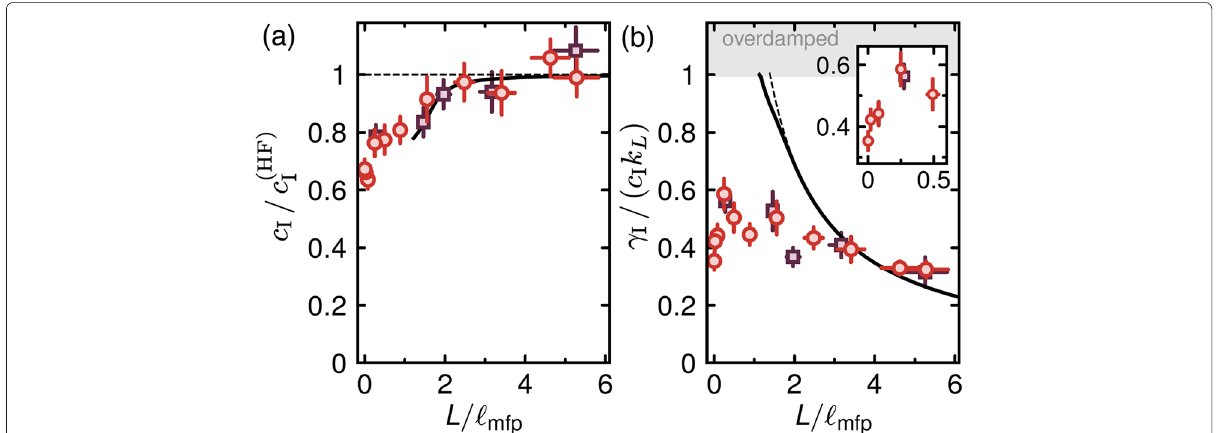
Fig. 22 The first sound velocity ( a ) and its relative damping rate ( b ) of a 3D interacting Bose gas as a function of the inverse Knudsen number L / l mfp in its normal state at T (cid:3) 1.3 T c . The first sound velocity is measured in units of c HF , given in Eq. (24). For large L / l mfp , the data approach the results of the full hydrodynamic calculation (solid lines). The inset in b highlights the damping in the collisionless limit. Adapted from Ref.